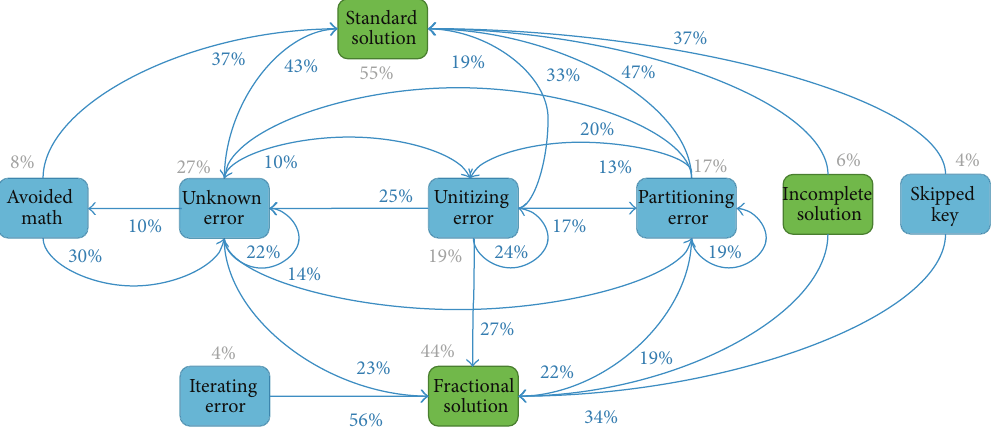
Figure 2: State transition diagram for Level